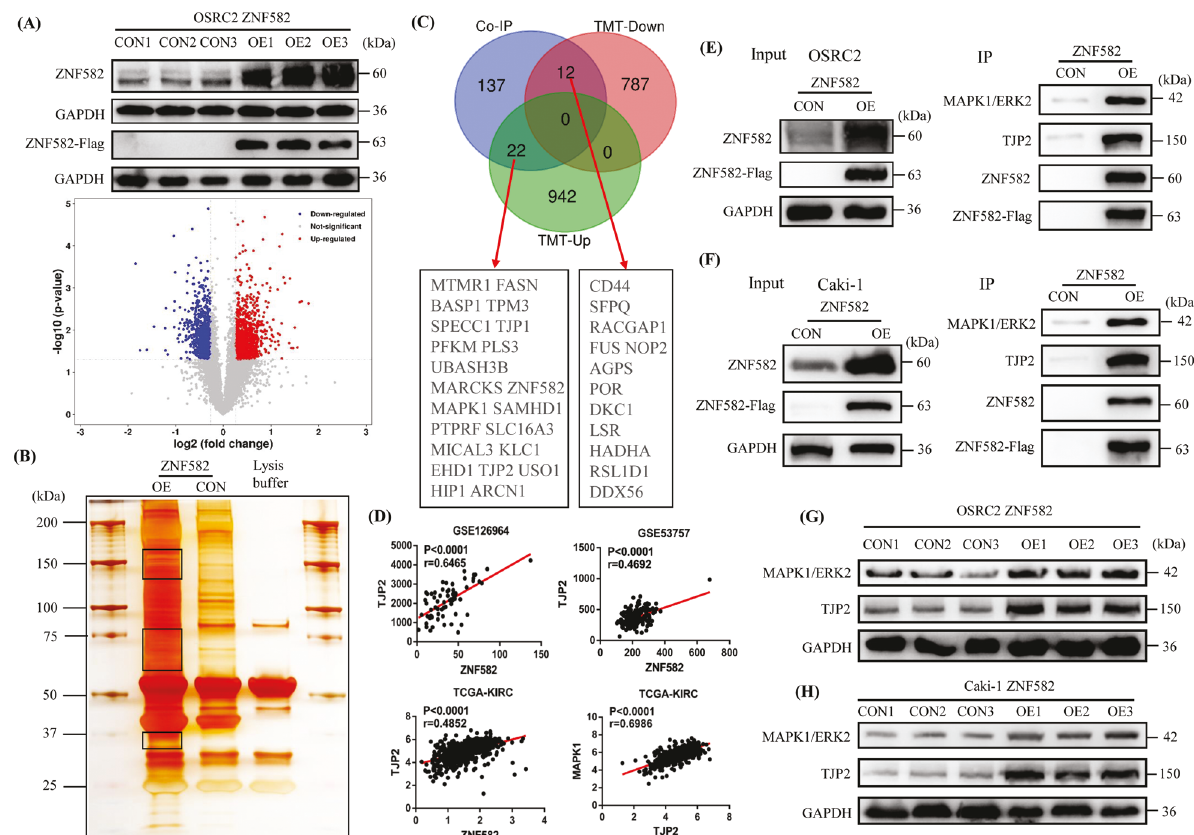
Fig. 3 ZNF582 protein binds to TJP2 and ERK2 protein and regulates their expression. A Comparison of the differential protein between ZNF582 overexpression and control OSRC2 cells by TMT experiment. B Identi fi cation of the possible binding proteins of ZNF582 protein by Co-IP, silver-staining and mass spectrometry. C Venn diagram analysis of TMT results and mass spectrometry results. D TJP2 expression is signi fi cantly positively correlated with ZNF582 expression based on GSE126964, GSE53757 and TCGA-KIRC data, and MAPK1 (ERK2) expression is signi fi cantly positively correlated with TJP2 expression based on TCGA-KIRC data. E , F Con fi rmation of ZNF582 protein binds to TJP2 and ERK2 protein in OSRC2 and Caki-1 cells by IP and Western Blot. G , H Comparison of TJP2 and ERK2 expression between ZNF582 overexpression and control OSRC2 and Caki-1